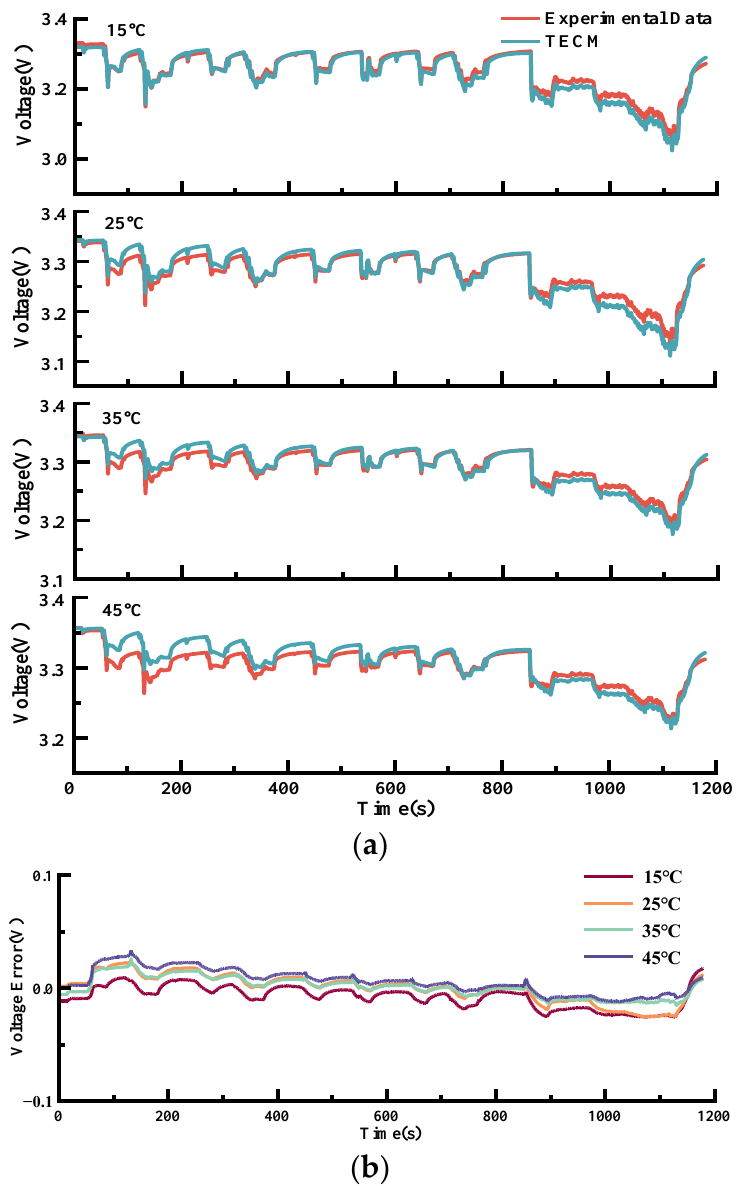
model is less than 0.03 V.